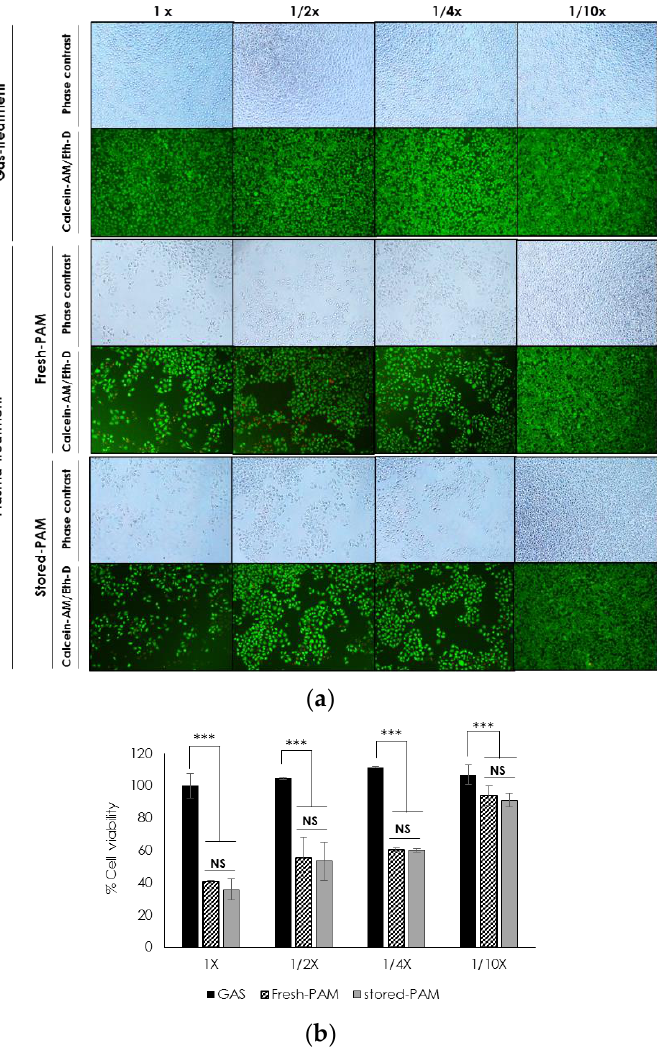
Figure 6. Quantitative assessment of anticancer efficacy of stock PAM. The fresh and 6-month stock PAM (1 × ) were diluted by 1/2, 1/4, and 1/10. HeLa cells were incubated in the diluted fresh and stock PAM for 24 h and then cell viability was evaluated by conducting live/dead assay ( a ) and MTT assay ( b ). NS: not significant; * p ≤ 0.05, ** p ≤ 0.01, *** p ≤ 0.001.